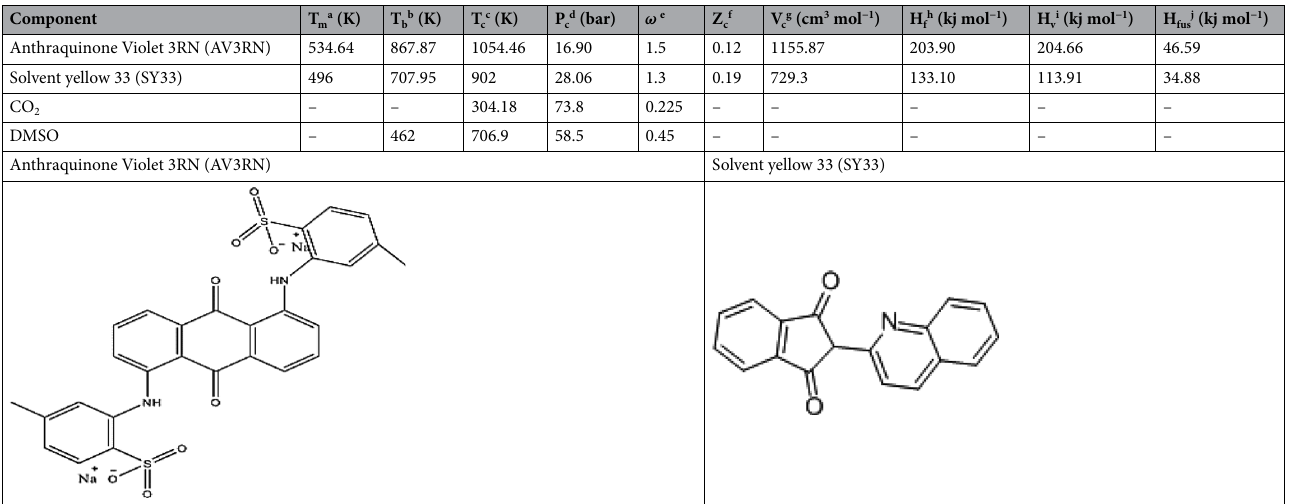
Table 1. Critical and physical properties of pure solvents and solutes. a Normal melting point. b Normal